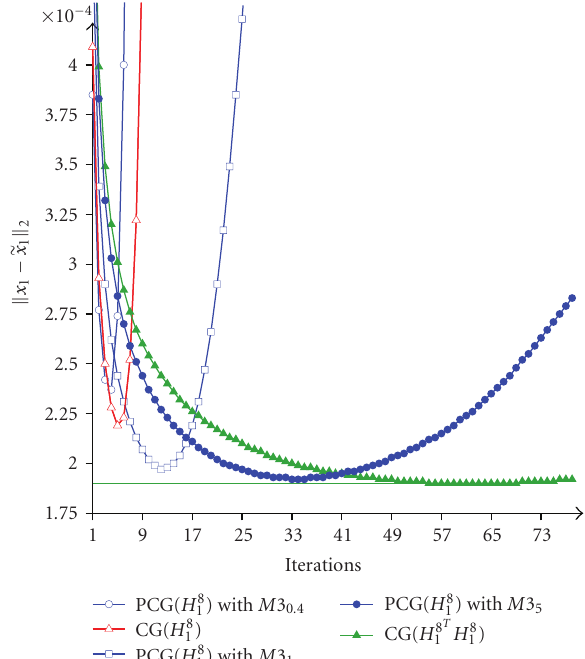
Figure 3: Reconstruction error against the iteration for the 1D operator H 8 1 and original data x 1 of size n = 10 3 a ff ected by random noise of order 0.01%. CG is compared to PCG using the optimal preconditioner M 3 ρ (43) for di ff erent weights ρ .